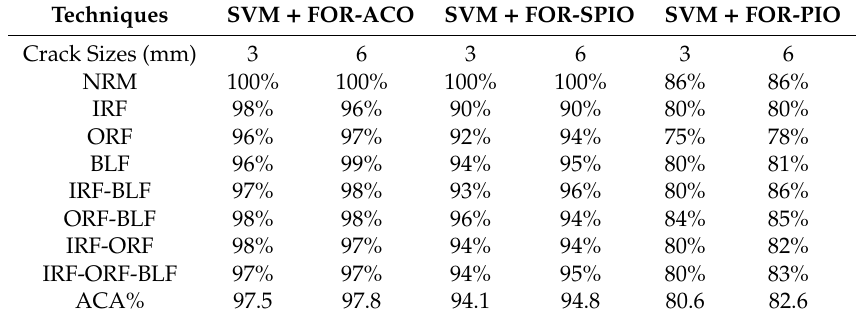
Table 14. The Accuracy of Multi-Type Fault Identification to Test the Motor Speed-Variant Dataset. Techniques SVM + FOR-ACO SVM +